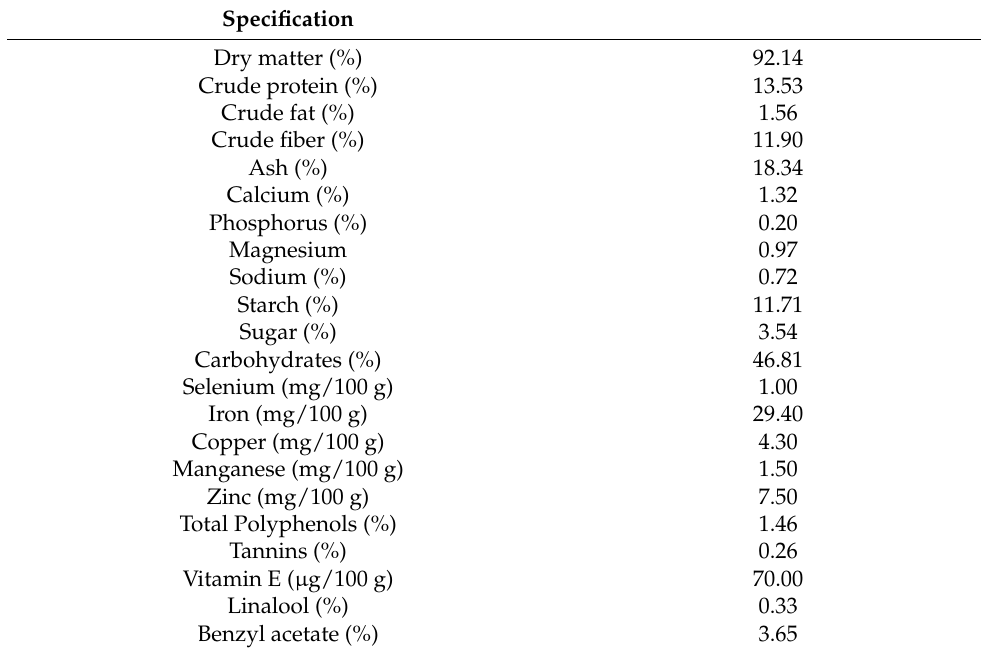
Table 2. Nutrient 1 and phytochemical 2 content of